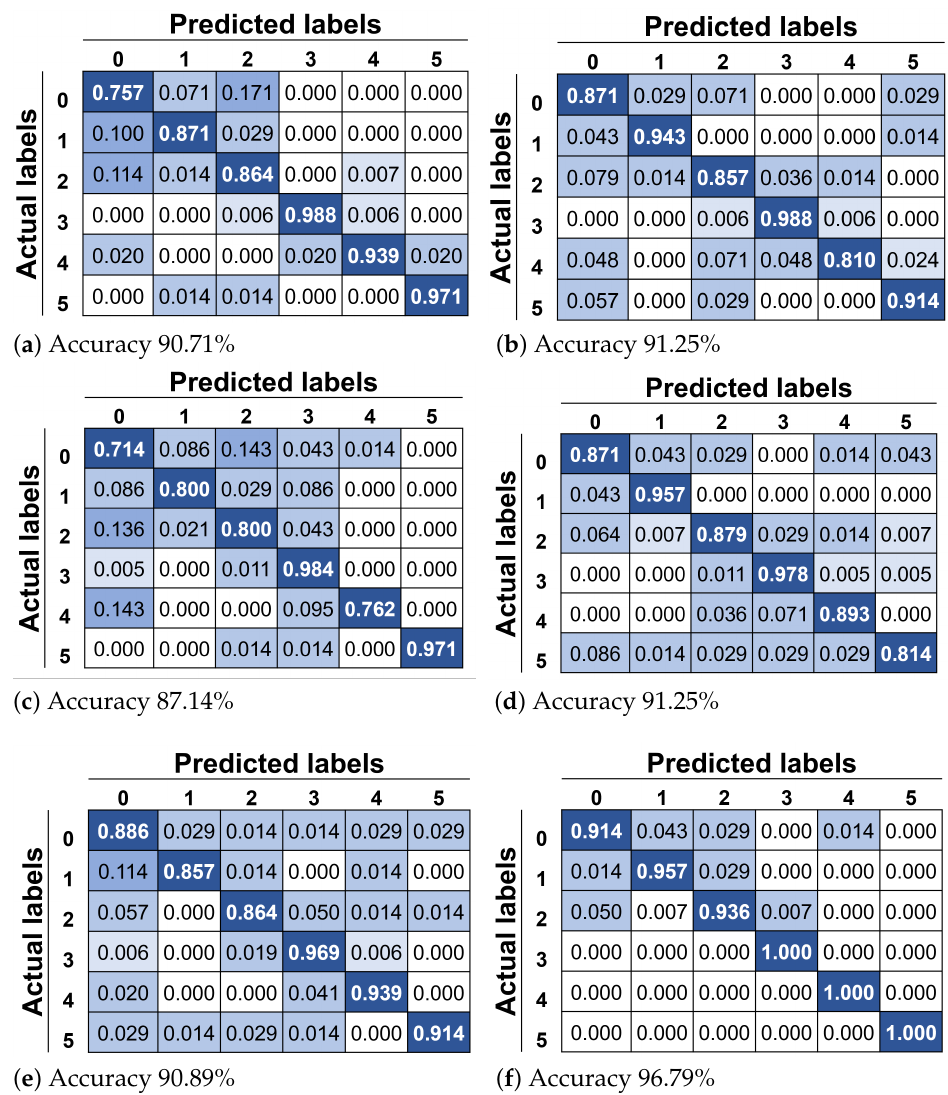
Figure 6. Confusion matrix with actual and predicted labels for test: ( a ) normal, ( b ) near-normal, ( c ) mild, ( d ) moderate, ( e ) severe, and ( f ) complete paralysis. Class 0 refers to neutral face, class 1 to eyebrow elevation, class 2 to eye closure, class 3 to wide-open smile, class 4 to closed mouth smile, and class 5 to